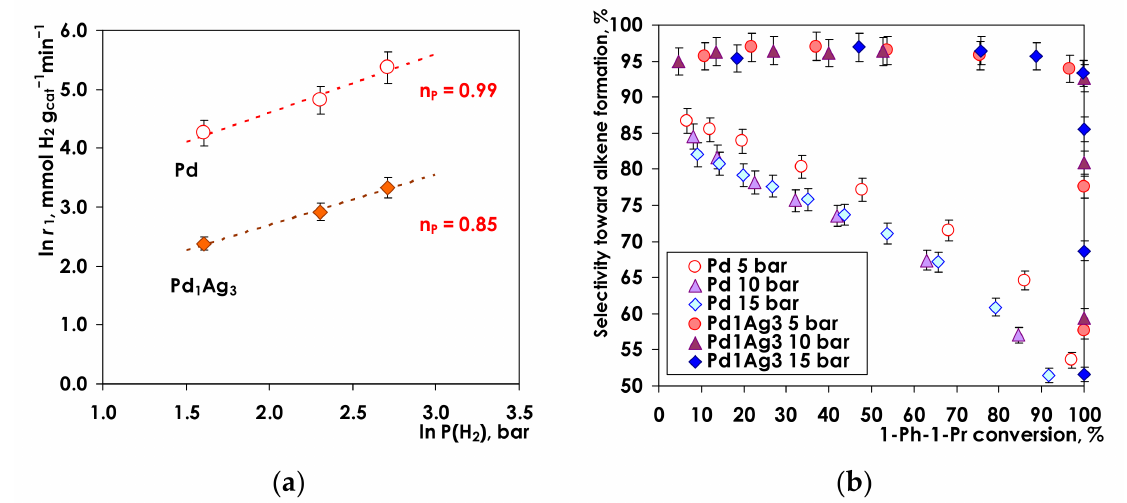
Figure 8. ( a ) Reaction rate vs. hydrogen pressure, ( b ) Selectivity toward alkene vs. 1-Ph-1-Pr conversion at different H 2 pressures. Conditions: T = 25 ◦ C, V C6H14 = 6 mL, m(Pd) = 1.5 mg, m(Pd 1 Ag 3 )= 7.5 mg. The error bars are ± 1 standard